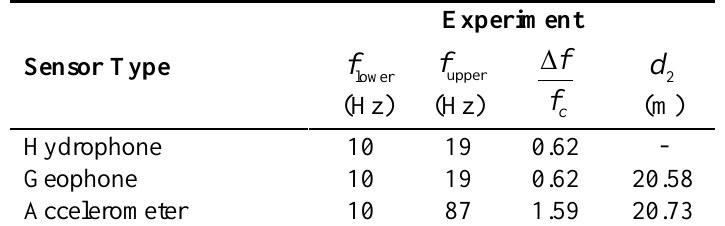
Table 4. Key parameters determined from the weak leak data (experiment